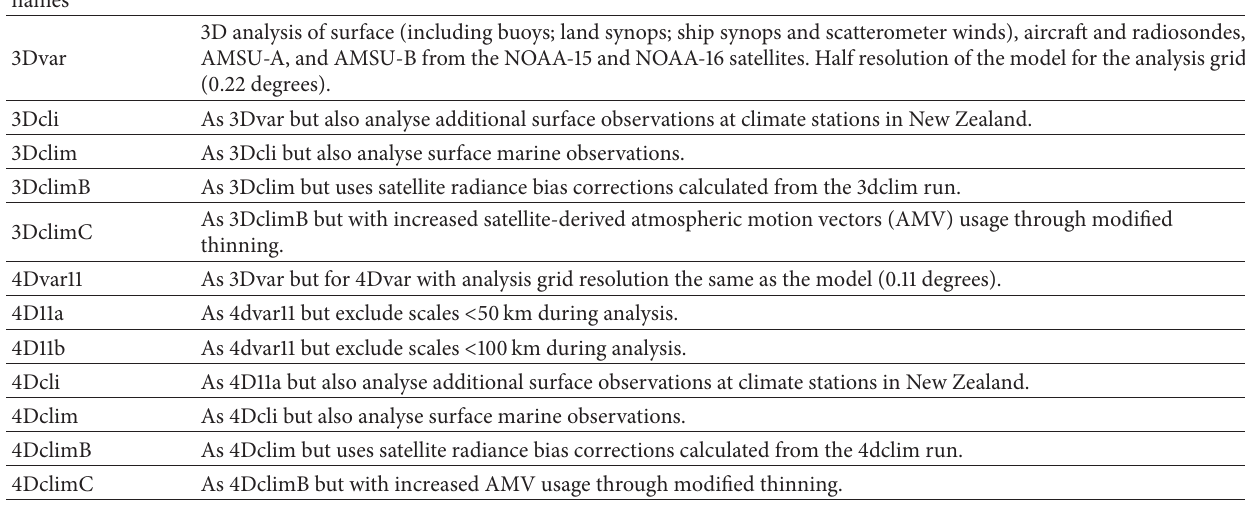
Table 1: Description of the 12 ensemble members used in this